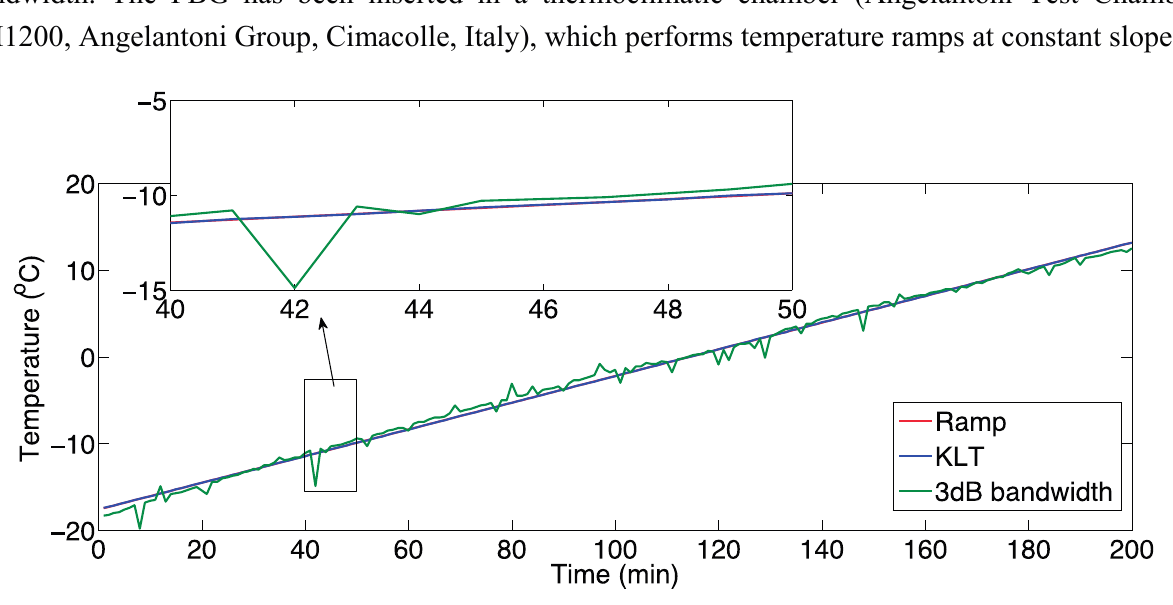
Figure 17. Experimental measurement of temperature with an FBG, in a climatic